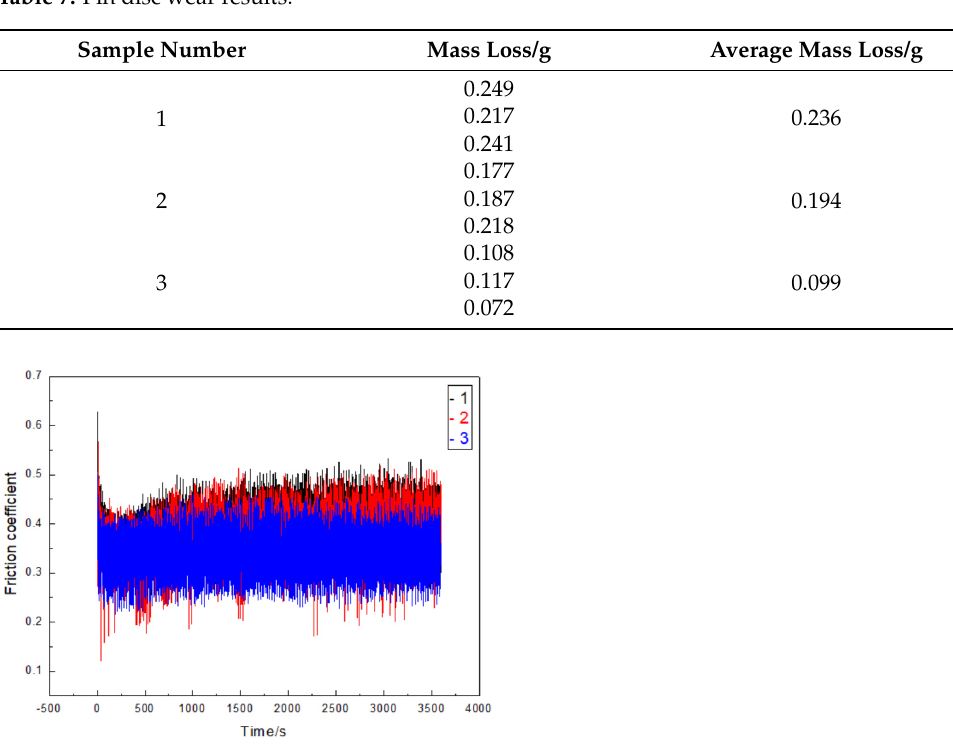
Table 7. Pin disc wear results.